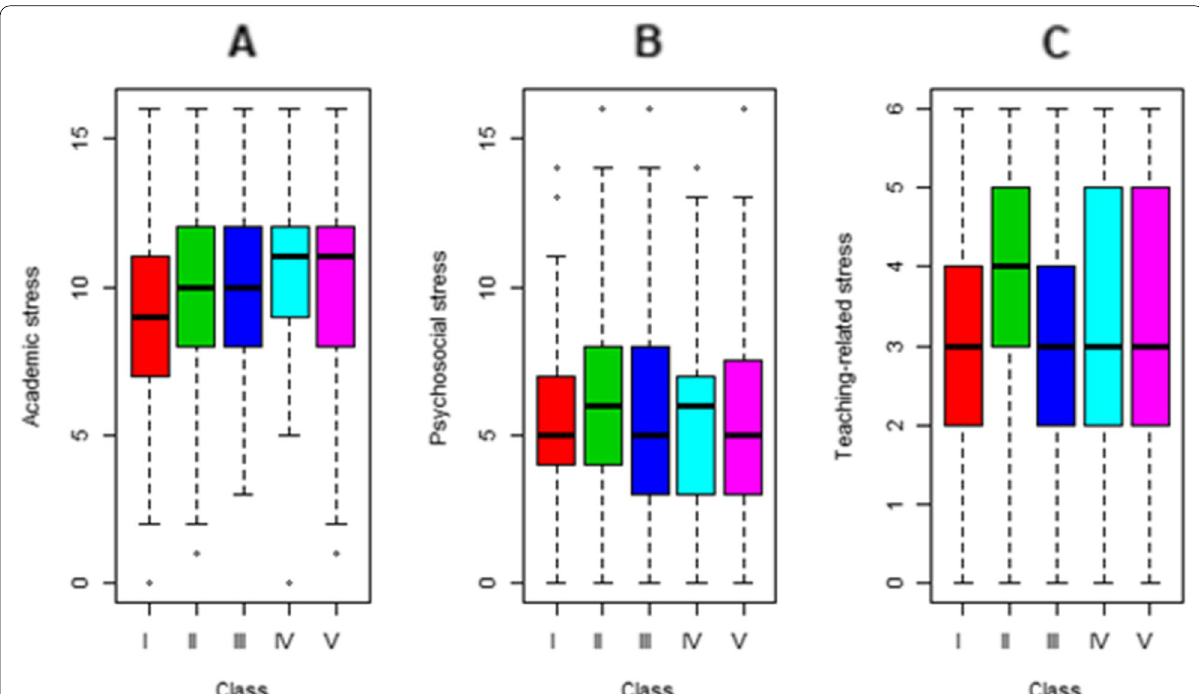
Fig. 2 Academic, psychosocial, and teaching-related stressors broken up by student class. The box-and-whisker plots represent the stress scores ( A Academic, B Psychosocial, C Teaching-related) broken-up by student current class. Note that the borders of the box represent the first and third quartiles (width indicates the interquartile range) and the whisker terminals represent the maximum and minimum score. The median score is represented by the thick black line in the middle of the box. Final year students were more academically stressed than first year students. Also, second year students reported higher teaching-related stress than other classes. Note that in the text it mentions “for inadequacy in teaching-related stress mean score, first-year and third-year students were the least stressed classes (both 3.00), followed by the fourth-year (3.34) and then final-year students (mean 3.44) (Fig. 2C)”. However, on C above, all classes score was =